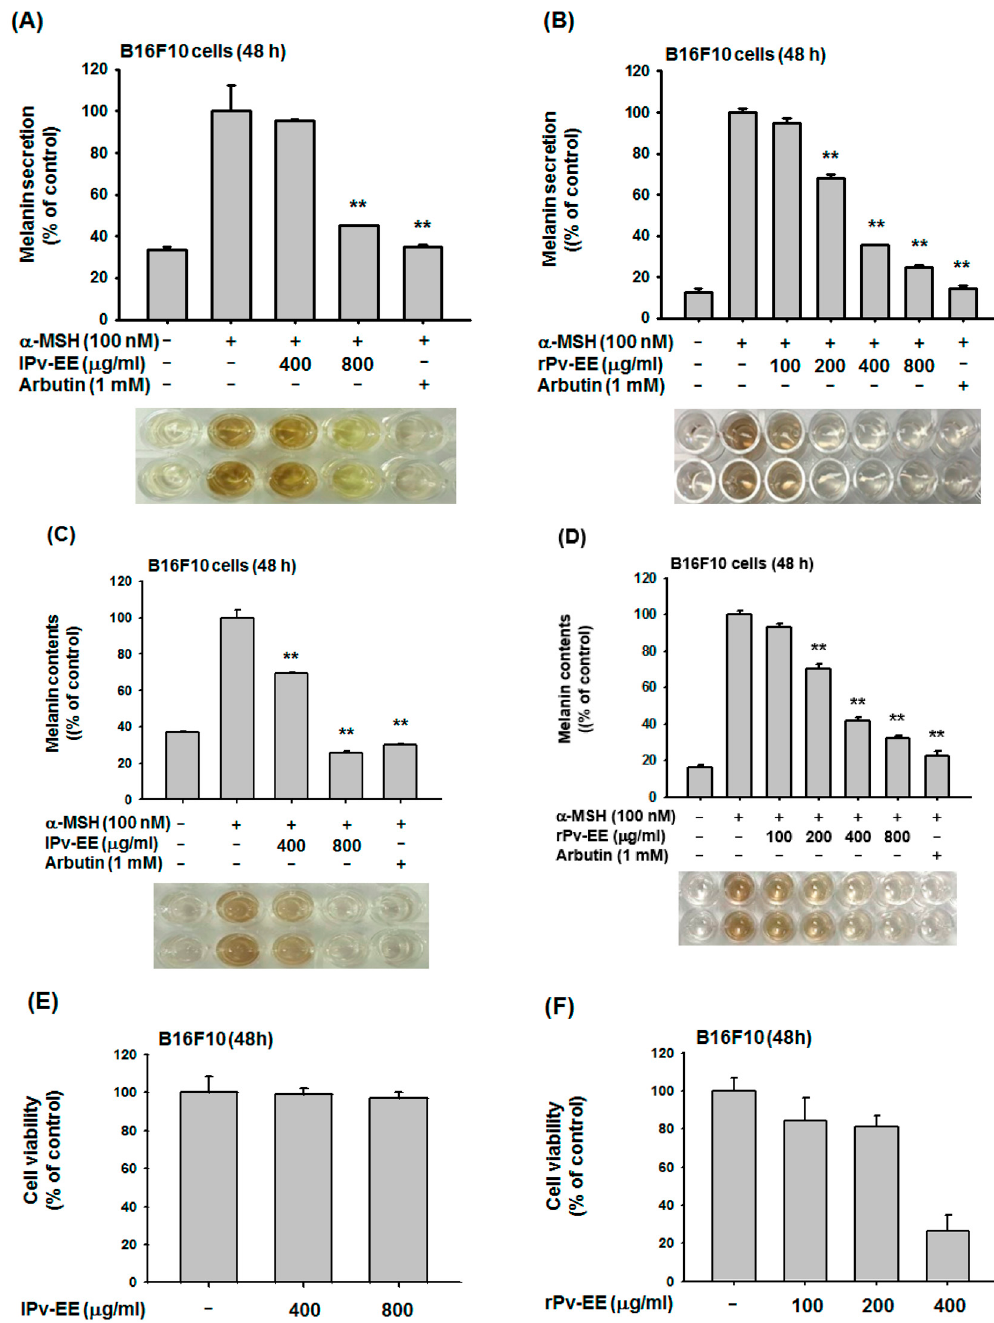
Figure 1. Anti-melanogenesis e ff ects of ethanol extracts of Patrinia villosa prepared fron leaf (lPv-EE) and root (rPv-EE) in α -melanocyte stimulating hormone ( α -MSH)-treated B16F10 Cells ( A – D ) The levels of melanin secretion and contents in B16F10 cells treated with -MSH (100 nM) in the presence or absence of lPv-EE (400 and 800 µ g / mL), rPv-EE (100 to 800 µ g / mL), or arbutin (1 mM) for 48 h. ( E , F ) Viability, determined using the MTT assay after 24 h, of B16F10 cells treated with various concentrations (400 and 800 µ g / mL) of lPv-EE or (100 to 400 µ g / mL) of rPv-EE. ** p < 0.01 compared to the control group.